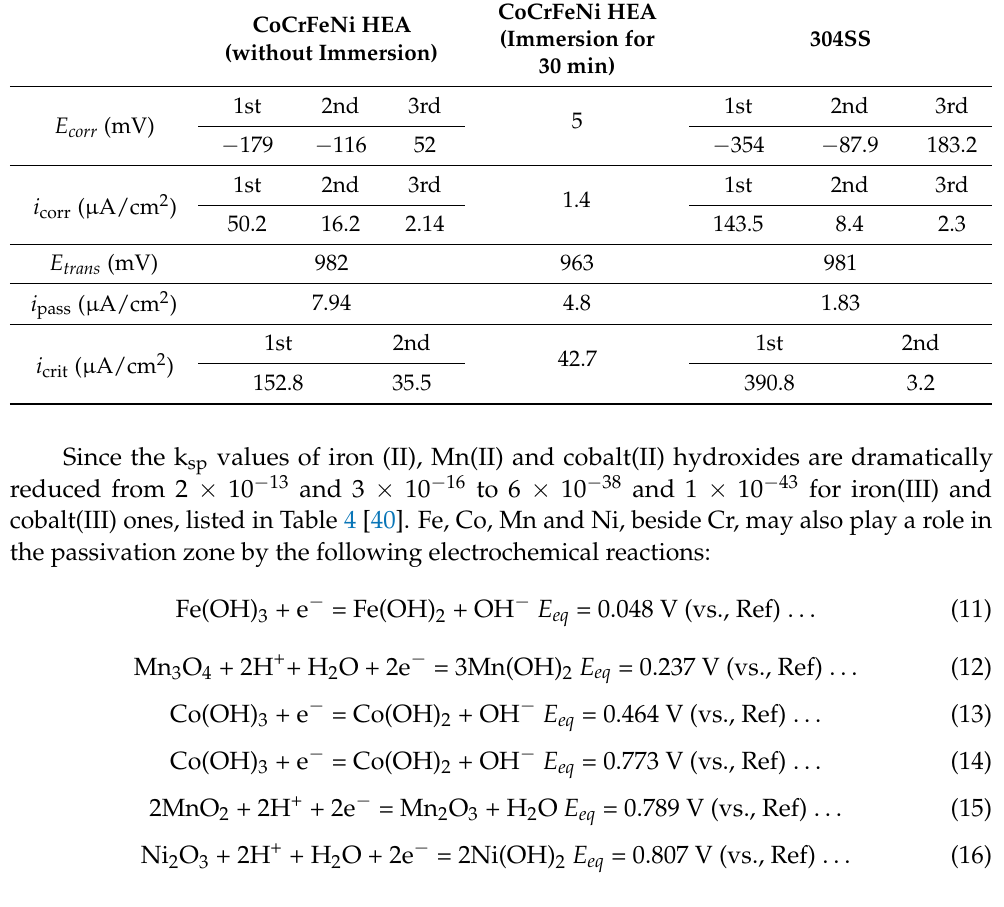
Figure 1. Potentiodynamic polarization curves of (a) CoCrFeNi HEA and (b) 304SS without pre- immersion in 0.5 M H 2 SO 4 (pH = 0.47) AAS. Table 2. Corrosion characteristics derived from polarization curves shown in Figure 1.